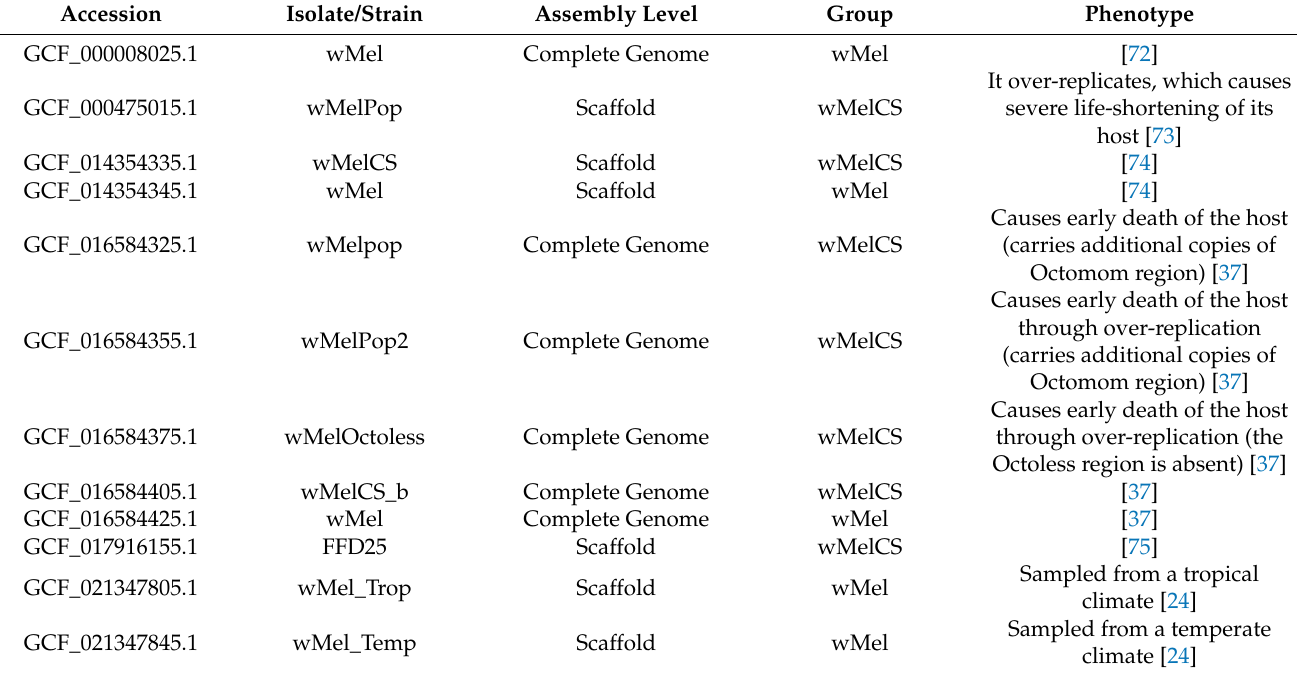
Table 5. The list of species under study (species for which proteomic data were collected) and corresponding assembly